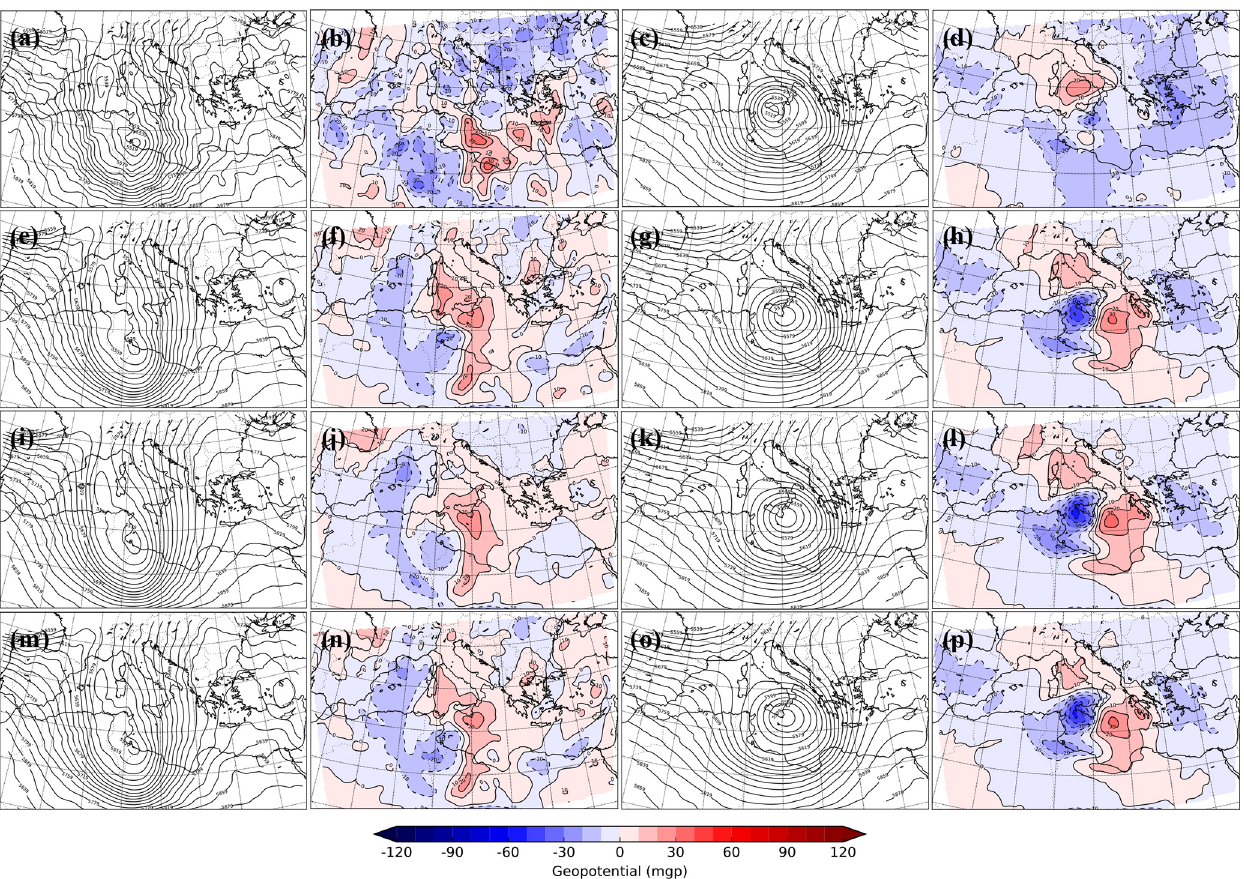
Figure 16. Comparison of the geopotential at 500hPa between the numerical experiments and the ERA5 analysis at 00:00UTC (initial conditions) and 18:00UTC (maximum intensity registered at Malta). NODA, SYN, RSAMV and CNTRL experiments are shown in the first, second, third and fourth row, respectively. 500hPa-geopotential is performed by the different experiments at 00:00 and 18:00UTC are shown in the first and third column, respectively, and the differences between ERA5 and the experiments are performed in the second and fourth column,